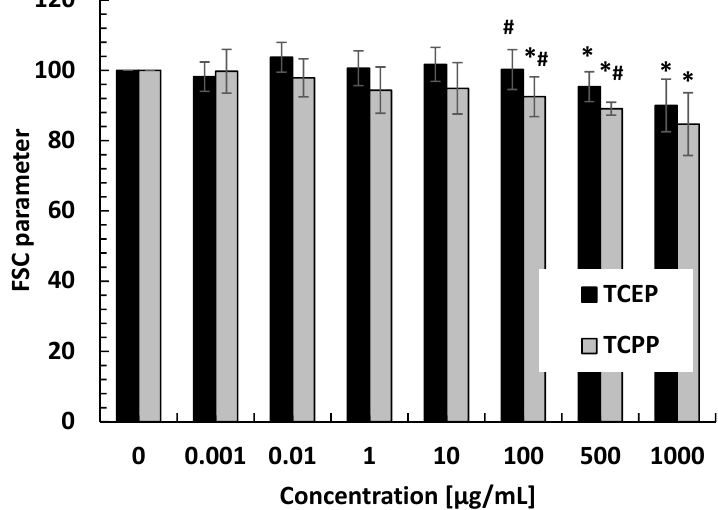
Figure 5. Changes in the FSC parameter in control erythrocytes and erythrocytes incubated with TCPP at concentrations ranging from 0.001 to 1000 μ g/mL for 24 h. * p < 0.05 indicates statistically significant difference from control. (#) statistically significant difference between TCPP and TCEP.